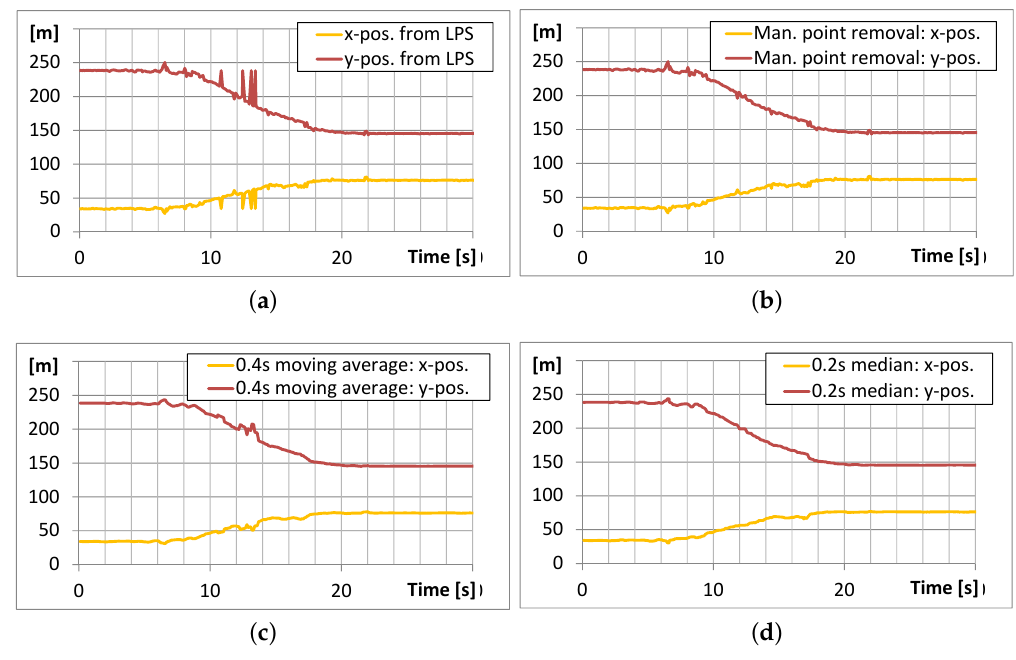
Figure 11. Example for the x- and y positions of one trajectory over time (Test 9) obtained from LPS system projected onto a virtual horizontal ground: ( a ) direct LPS output; ( b ) manual removal of singularities; ( c ) moving average of 0.4s intervals; ( d ) median using 0.2s